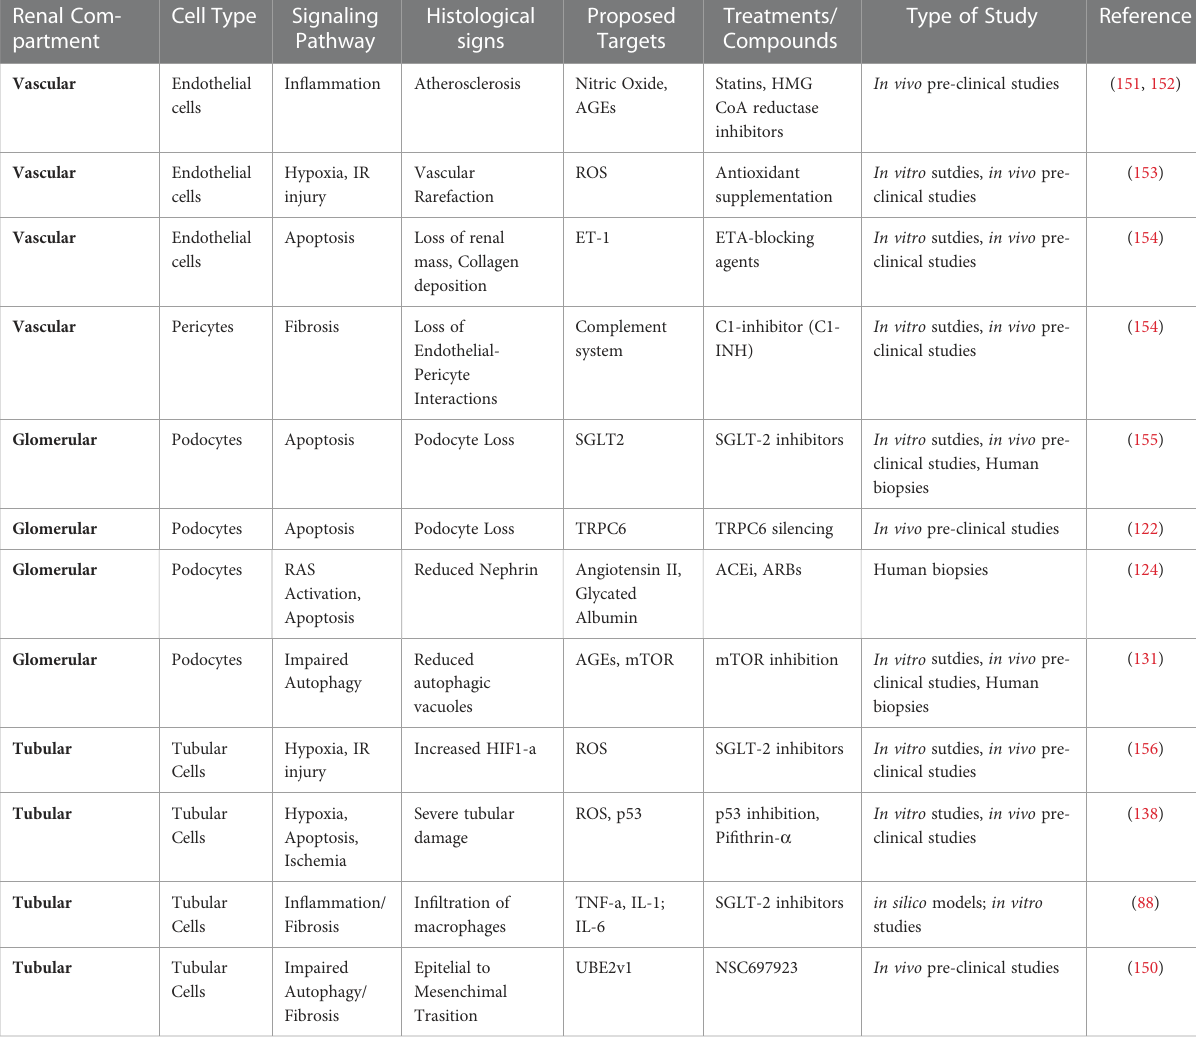
TABLE 1 Signaling pathways, target molecules and candidate treatments against maladaptive repair in AKI and diabetes. Renal